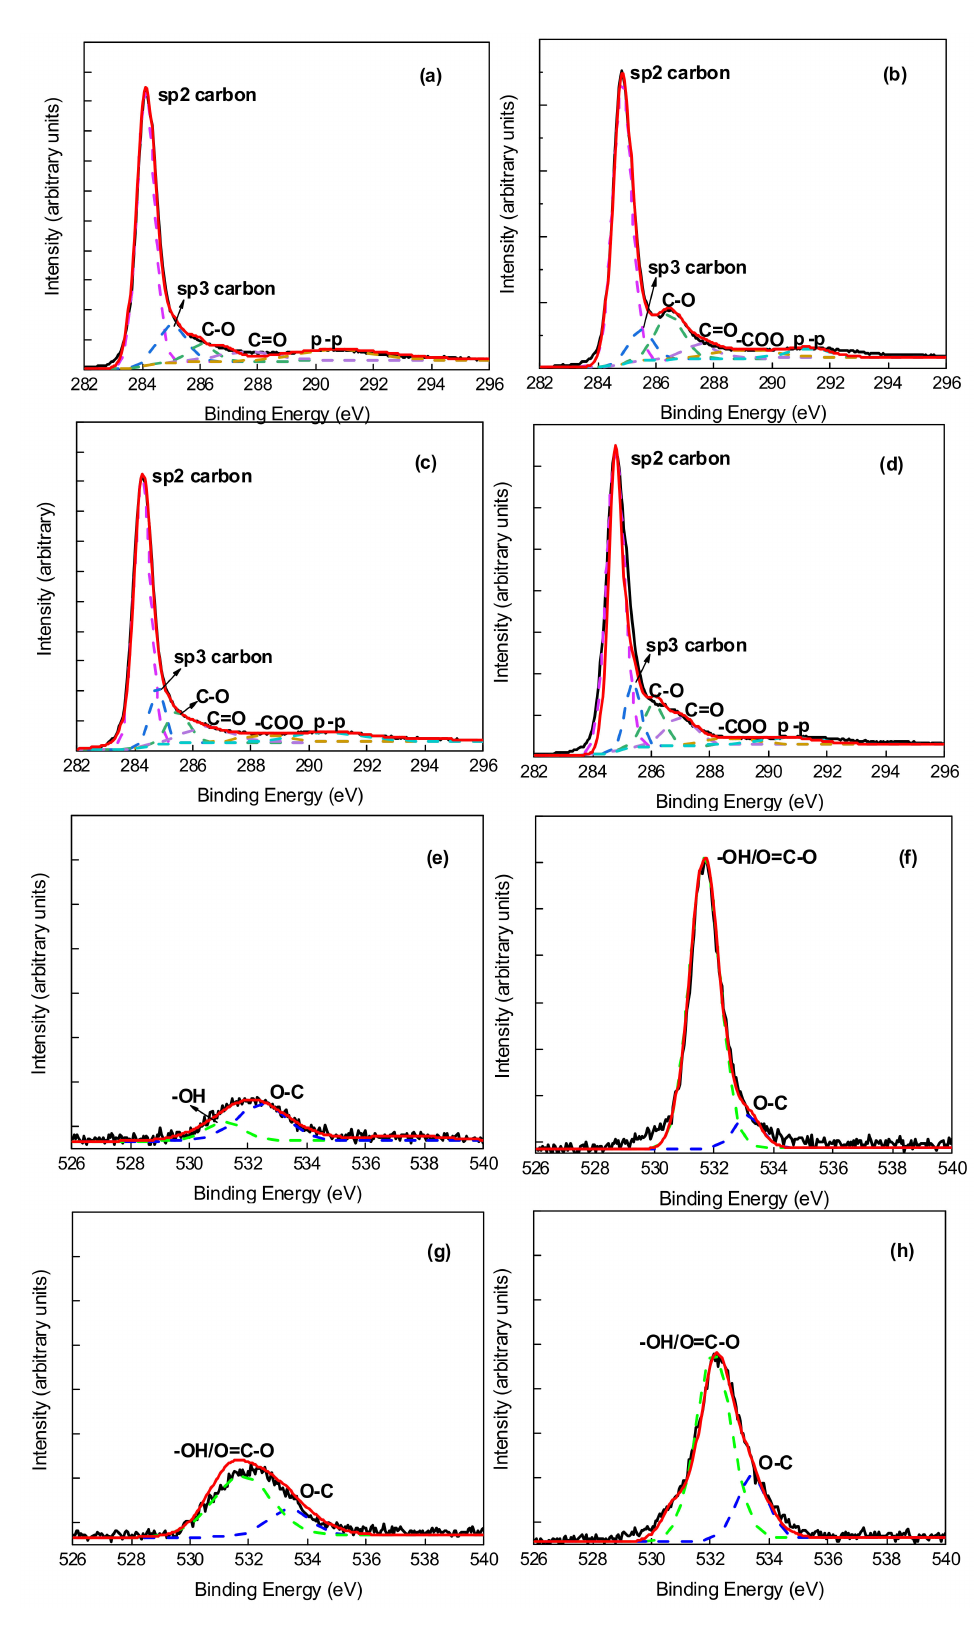
Figure 6. XPS C1s spectrum of ( a ) raw MWCNT membrane; ( b ) PEG–MWCNT membrane; ( c ) raw MWCNT– COOH membrane; ( d ) PEG–MWCNT– COOH membrane; XPS O1s spectrum of ( e ) raw MWCNT membrane; ( f ) PEG–MWCNT membrane; ( g ) raw MWCNT– COOH membrane; ( h ) PEG–MWCNT– COOH